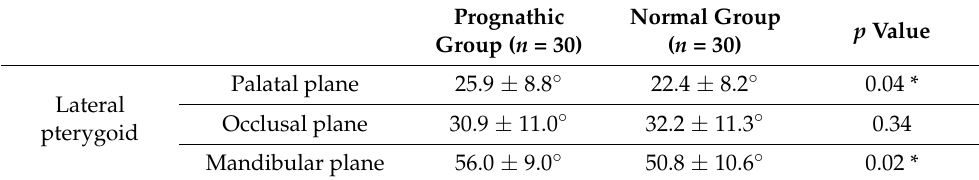
Table 2. Angle between lateral pterygoid and three reference